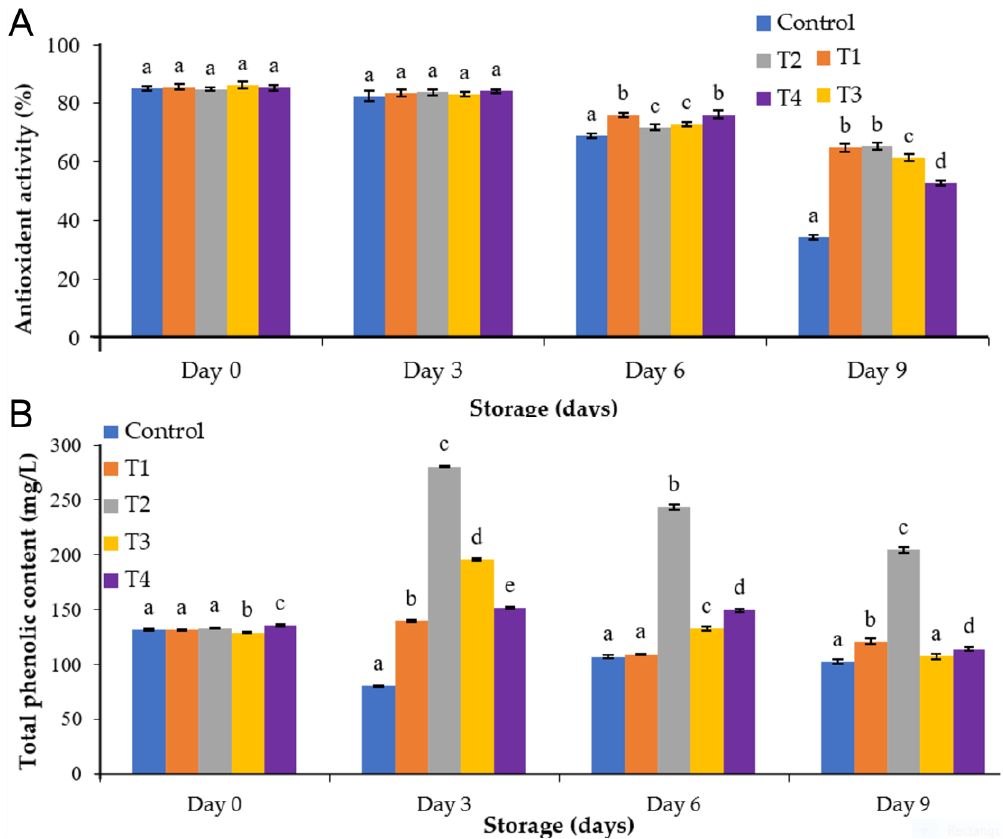
Figure 4. ( A ) Antioxidant scavenging activity and ( B ) total phenolic content of guava fruits at different maturity stages. Different lowercase letters (a – e) within the same group represent significant